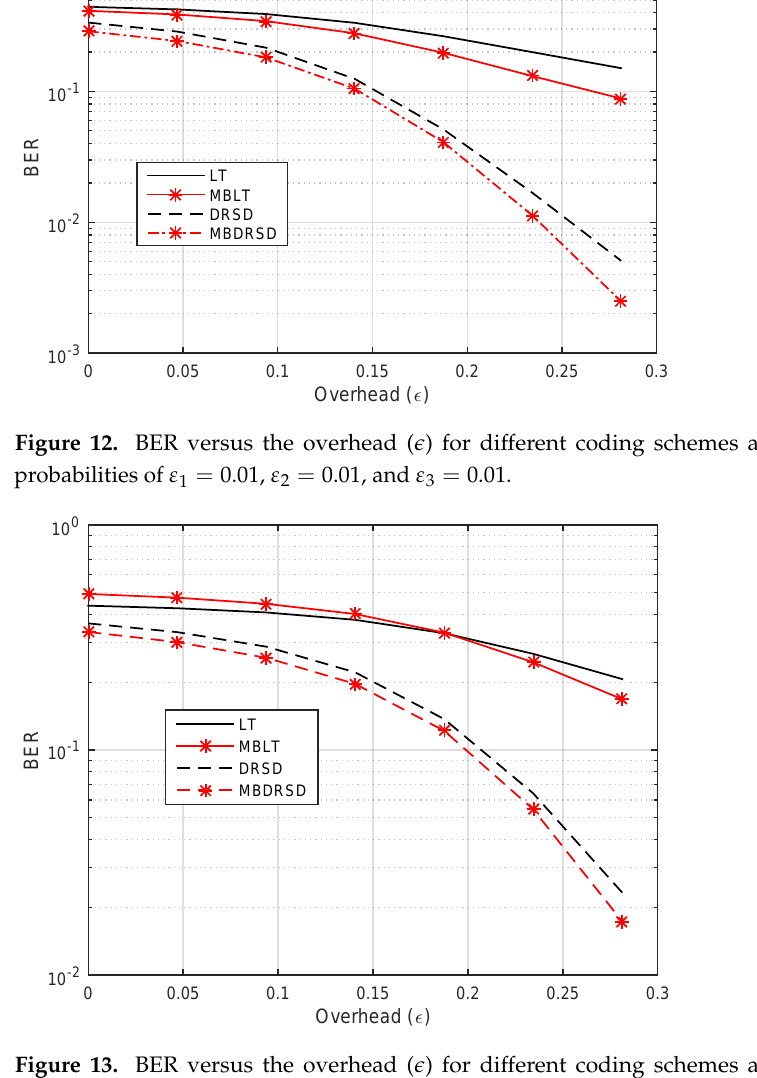
Figure 13. BER versus the overhead ( (cid:101) ) for different coding schemes at k = 256 and erasure probabilities of ε 1 = 0.01, ε 2 = 0.01, and ε 3 =